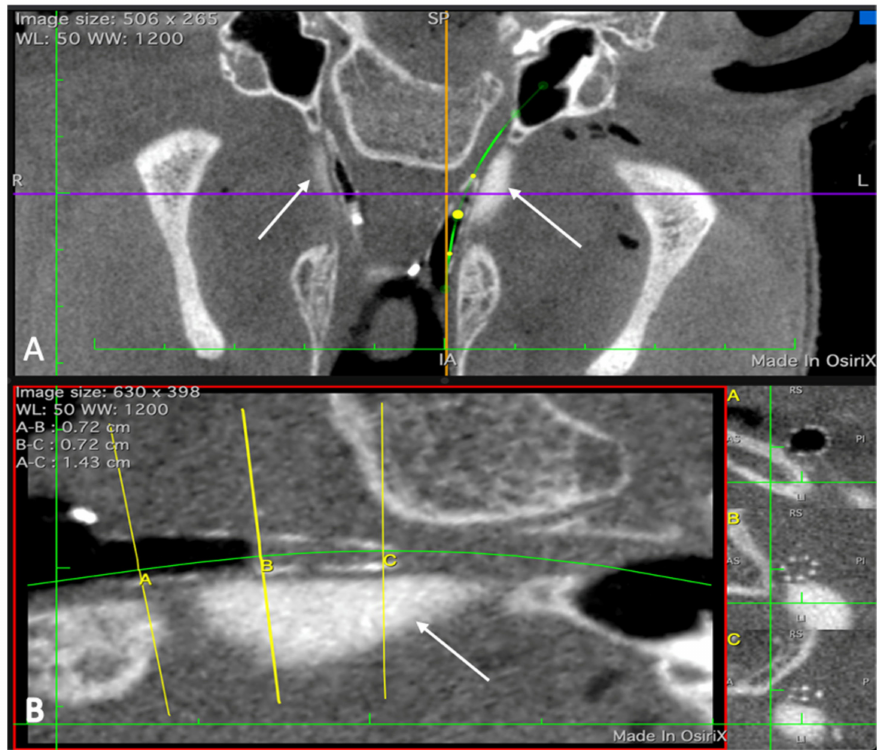
Figure 5. CBCT scan of a head with stent prototypes inserted into the ETs. ( A ): Both depots (cases 1 (left ET) and 2 (right ET)) are visible and marked by white arrows. Next to the depots, air filled stents can be seen. The green line indicates the course of the left ET. ( B ): Enlargement of one stented ET with the depot. The yellow lines (A; B; C) mark the position of the respective cross sections depicted on the right